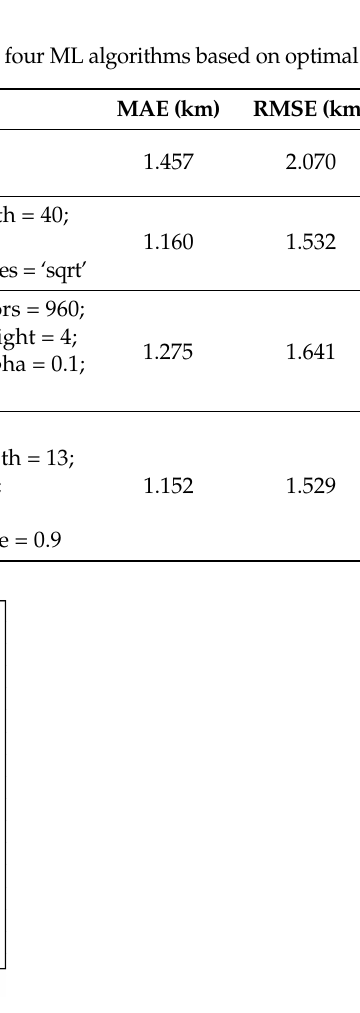
Figure 10. MAE and RMSE comparison of four ML